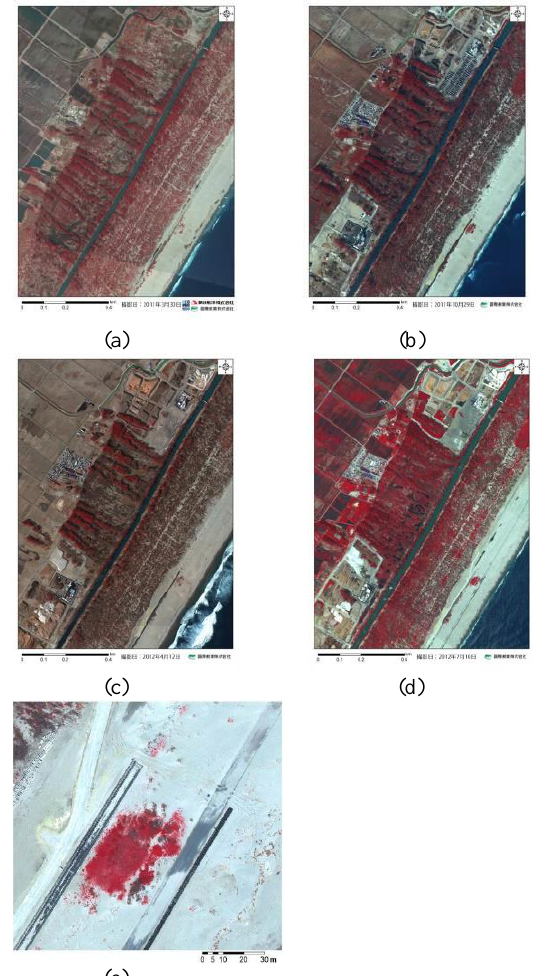
Figure 6(a), (b), (c), (d). Very fine resolution (10 cm) aerial photographs (DMC-2) for a section of Sendai Bay coastline. Photos taken on 31 st March 2011 (a), 29 th October 2011 (b), 12 th April 2012(c), 10 th July 2012 (d). Figure 6(e). Zoom-in view of Figure 6(d), showing patch of recovering coastal vegetation.